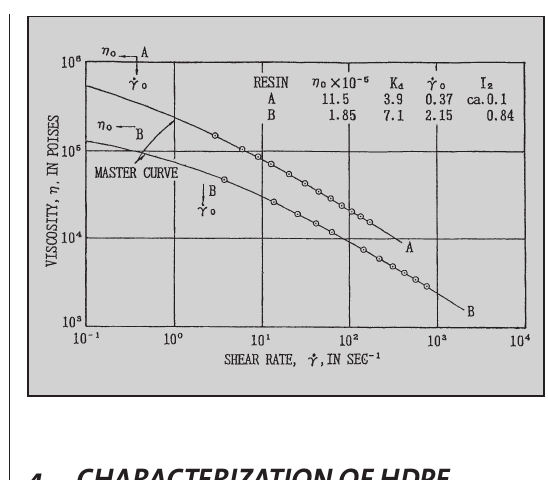
Figure 1: Examples of capillary flow data and two-parameter curve fitting-perfect